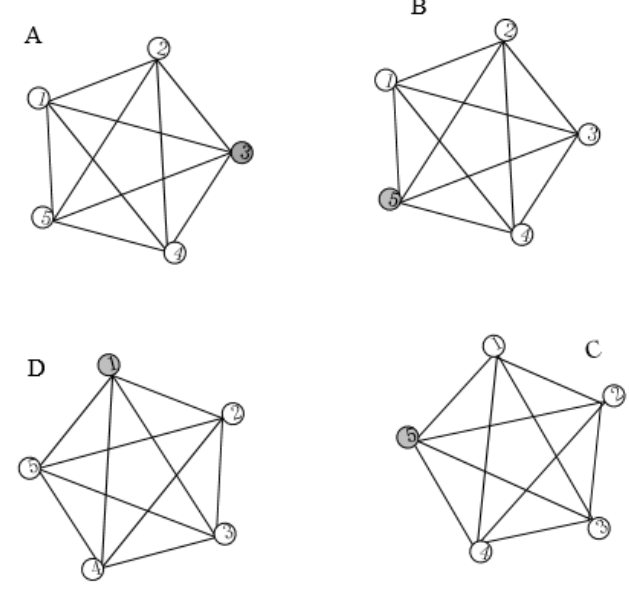
Figure 6. Individual